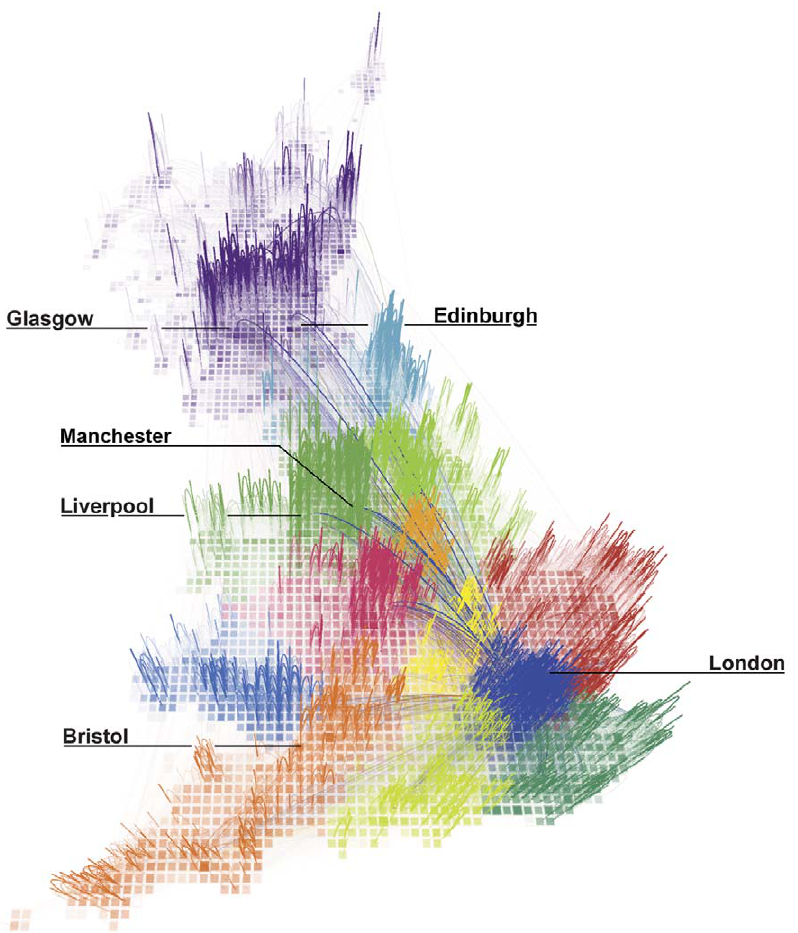
Figure 1. The geography of talk in Great Britain. This figure shows the strongest 80% of links, as measured by total talk time, between areas within Britain. The opacity of each link is proportional to the total call time between two areas and the different colours represent regions identified using network modularity optimisation analysis.